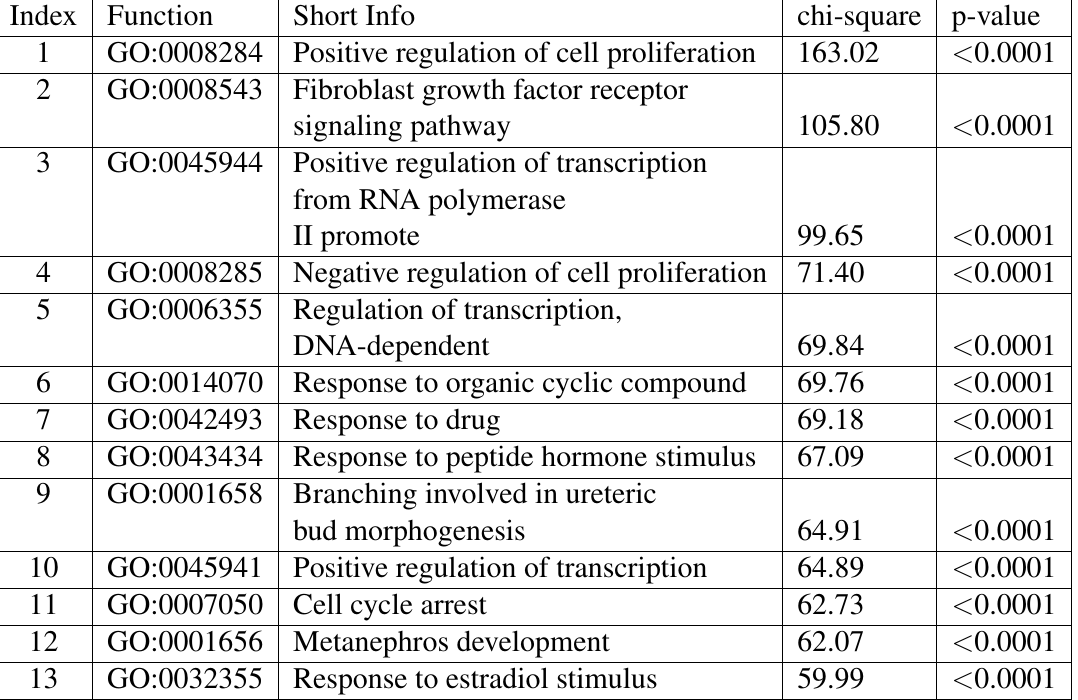
Table 3: Most discriminative functions from Biological Process based on FS method.